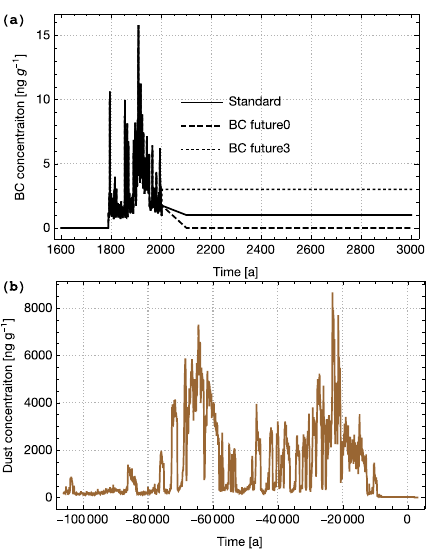
Figure 3. Aerosol time series of (a) black carbon (BC) and (b) dust. (a) The standard BC time series consists of ice core data by Mc- Connell et al. (2007) and projections based on Bauer et al. (2013) with two additional trajectories of the future. In the period before data are available the BC concentration is set to 0. (b) The dust con- centration from NGRIP (Ruth, 2007), where the missing Holocene period (after − 8ka) is assigned a constant value of 20 ngg − 1 , and a value of 0 is assumed after the year